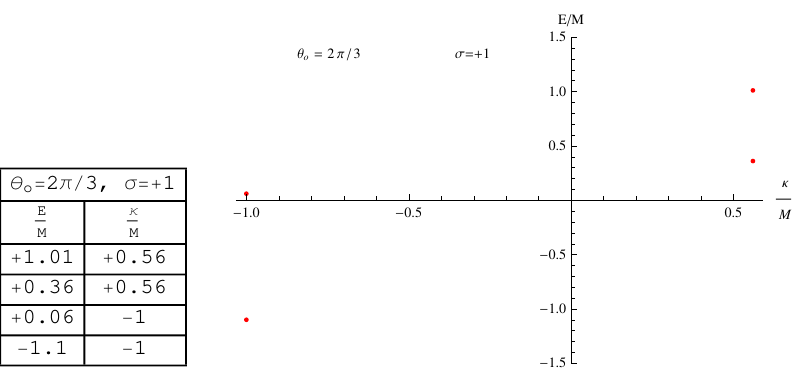
Figure 6 . The left table shows the E/M and κ/M values for θ 0 = 2 π/ 3 , σ = 1 .The right figure shows the points with coordinates ( κ/M , E/M ) . Notice the BIC states for E = +1 . 01 M, − 1 . 1 M .